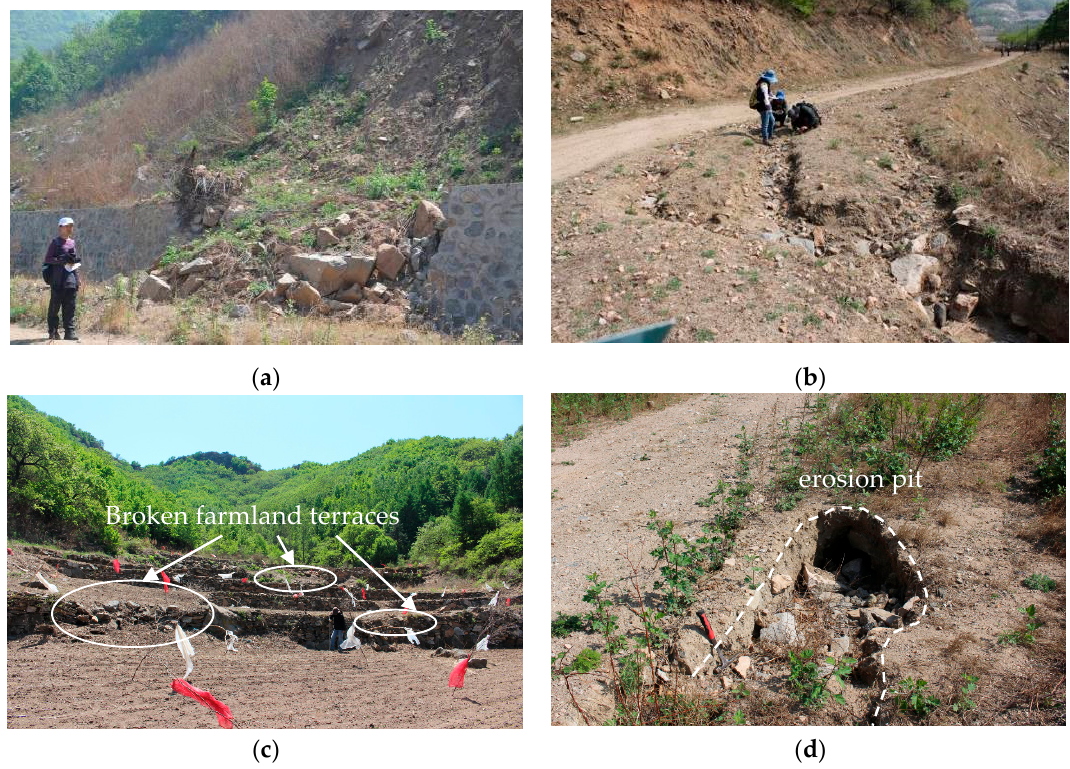
Figure 2. Mass-wasting in the field: ( a ) broken retaining wall; ( b ) erosion gully; ( c ) broken farmland terraces; and ( d ) erosion pit.